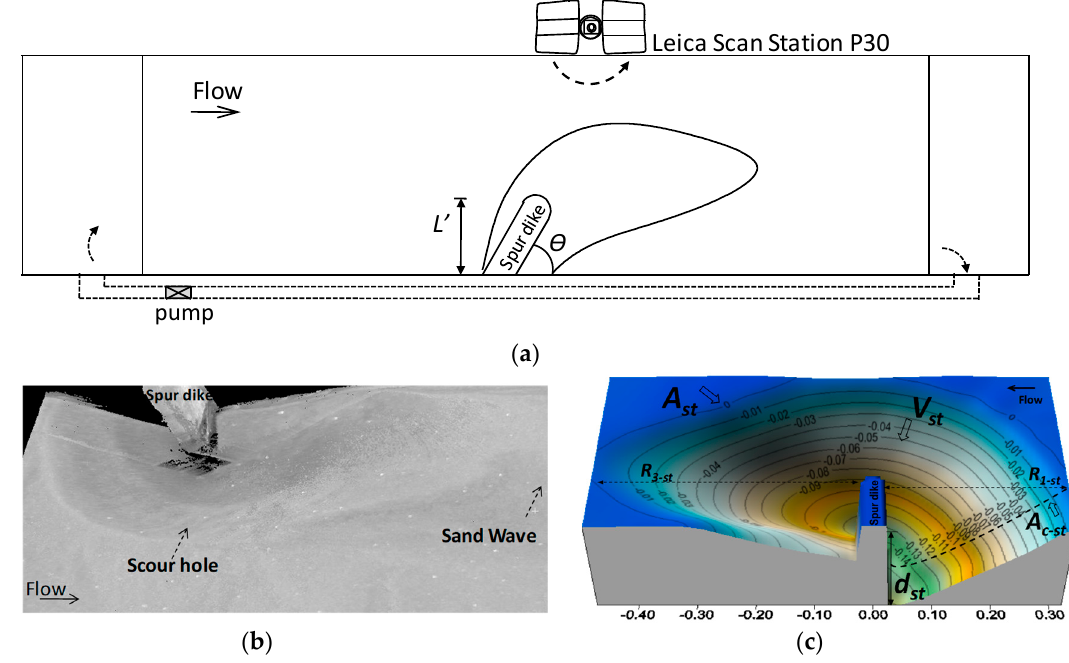
Figure 1. ( a ) Schematic diagram of flume experiment; ( b ) the point cloud data of scour hole topography; ( c ) Geometric characteristic parameters and characteristic length of scour hole (axis unit: m).